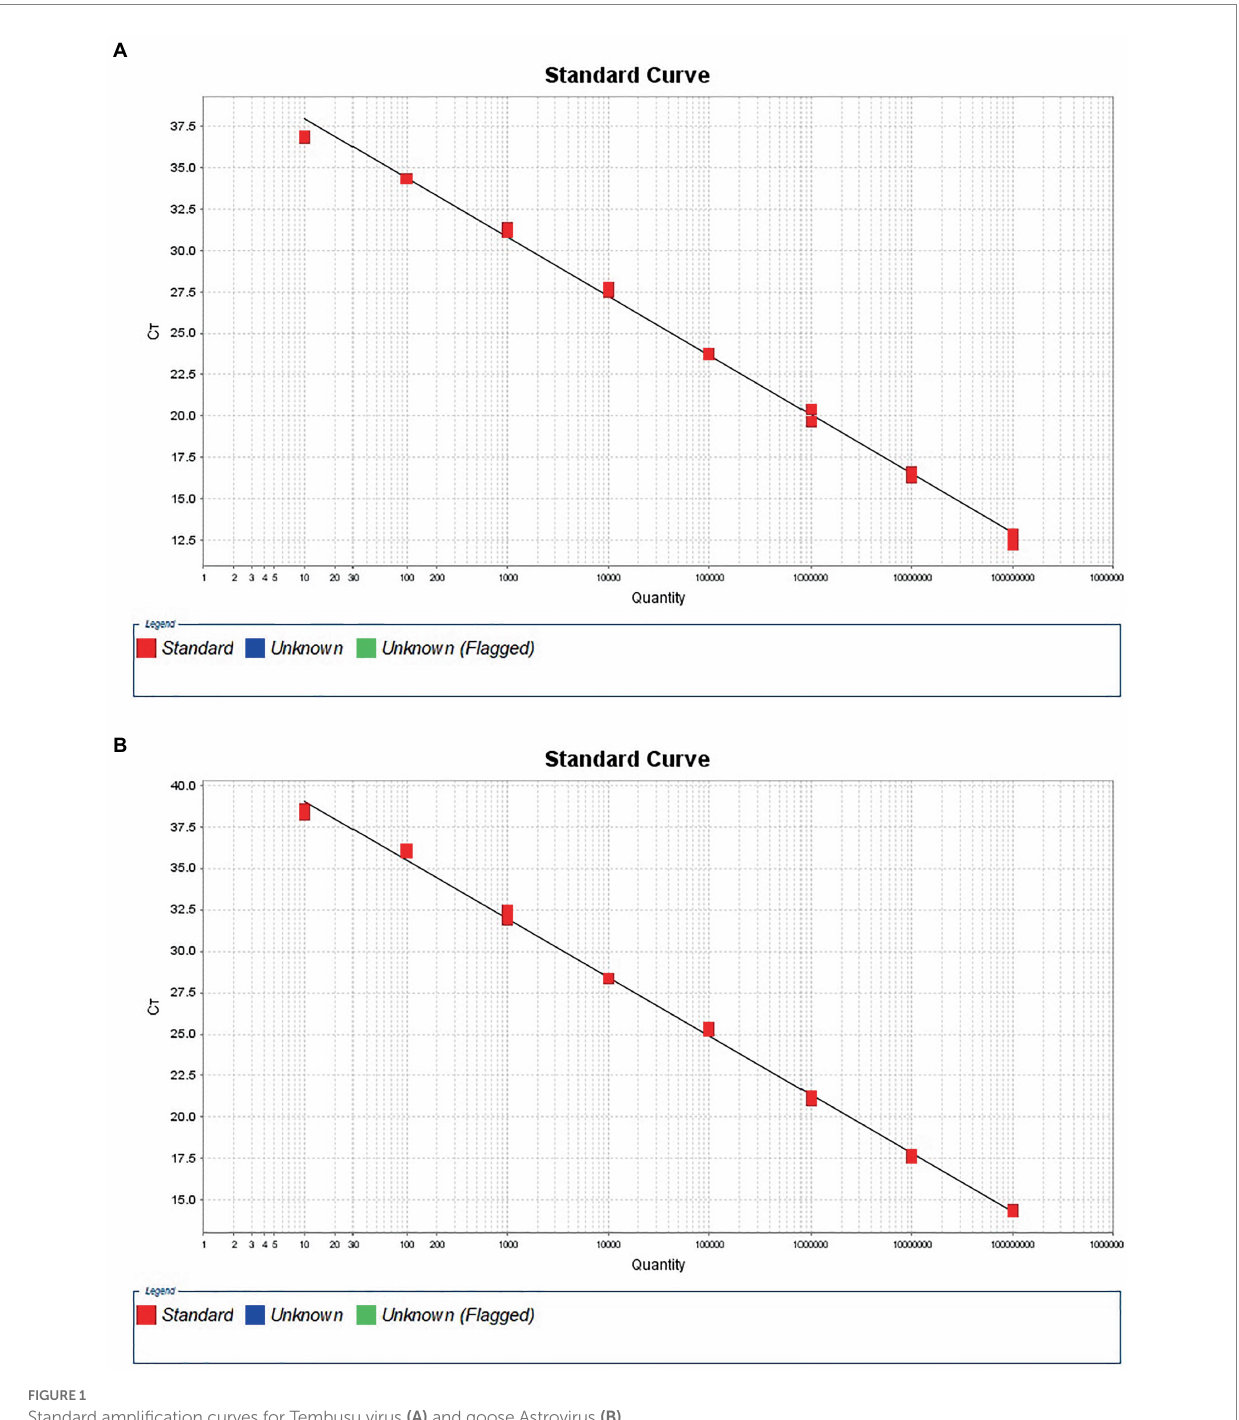
FIGURE 1 Standard amplification curves for Tembusu virus (A) and goose Astrovirus (B)